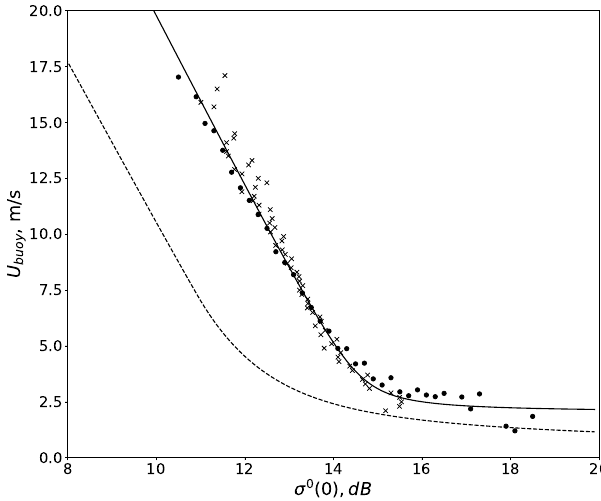
Figure 4. Wind speed from NDBC buoys dependent on NRCS at nadir. Dots correspond to averaged wind speed at a given NRCS, crosses correspond to averaged NRCS at a given wind speed. The solid line is the regression dependence for (4), the dashed line is the dependence from [7].